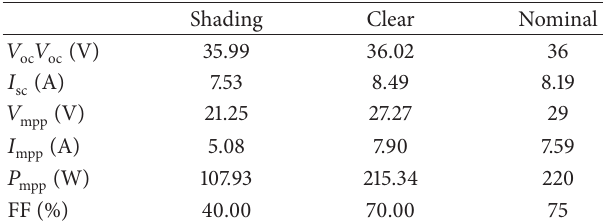
Table 5: Key parameters of the PV modules shaded by plant under STC.